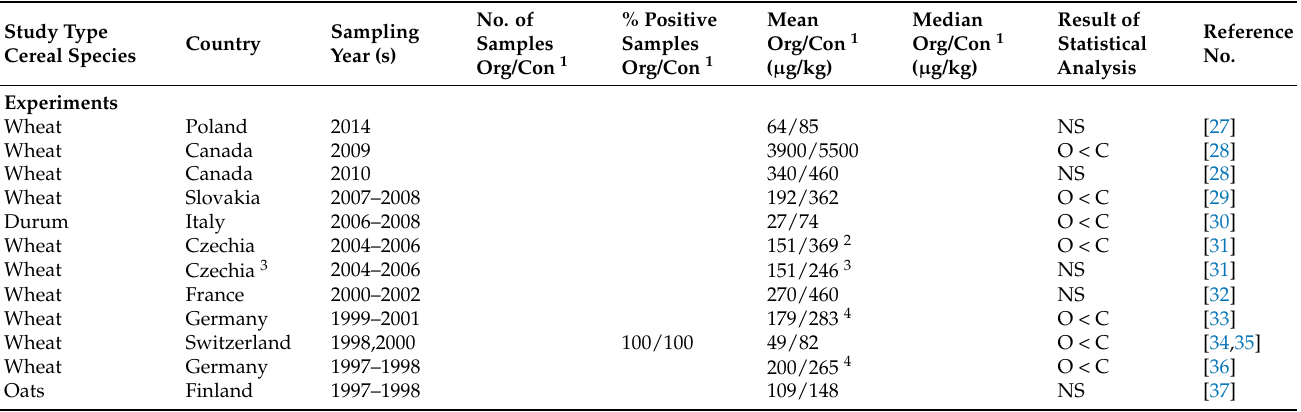
Table 1. Results from field-experiment- and farm-survey-based studies that compared deoxynivalenol (DON) concentrations in organically (org) and conventionally (con) produced cereal